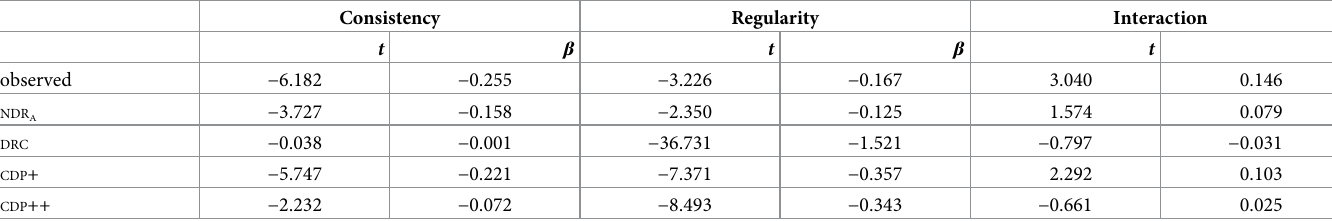
Table 2. The interplay of regularity and consistency. Listed are t -values and β coefficients for each of the predictors in an additive linear